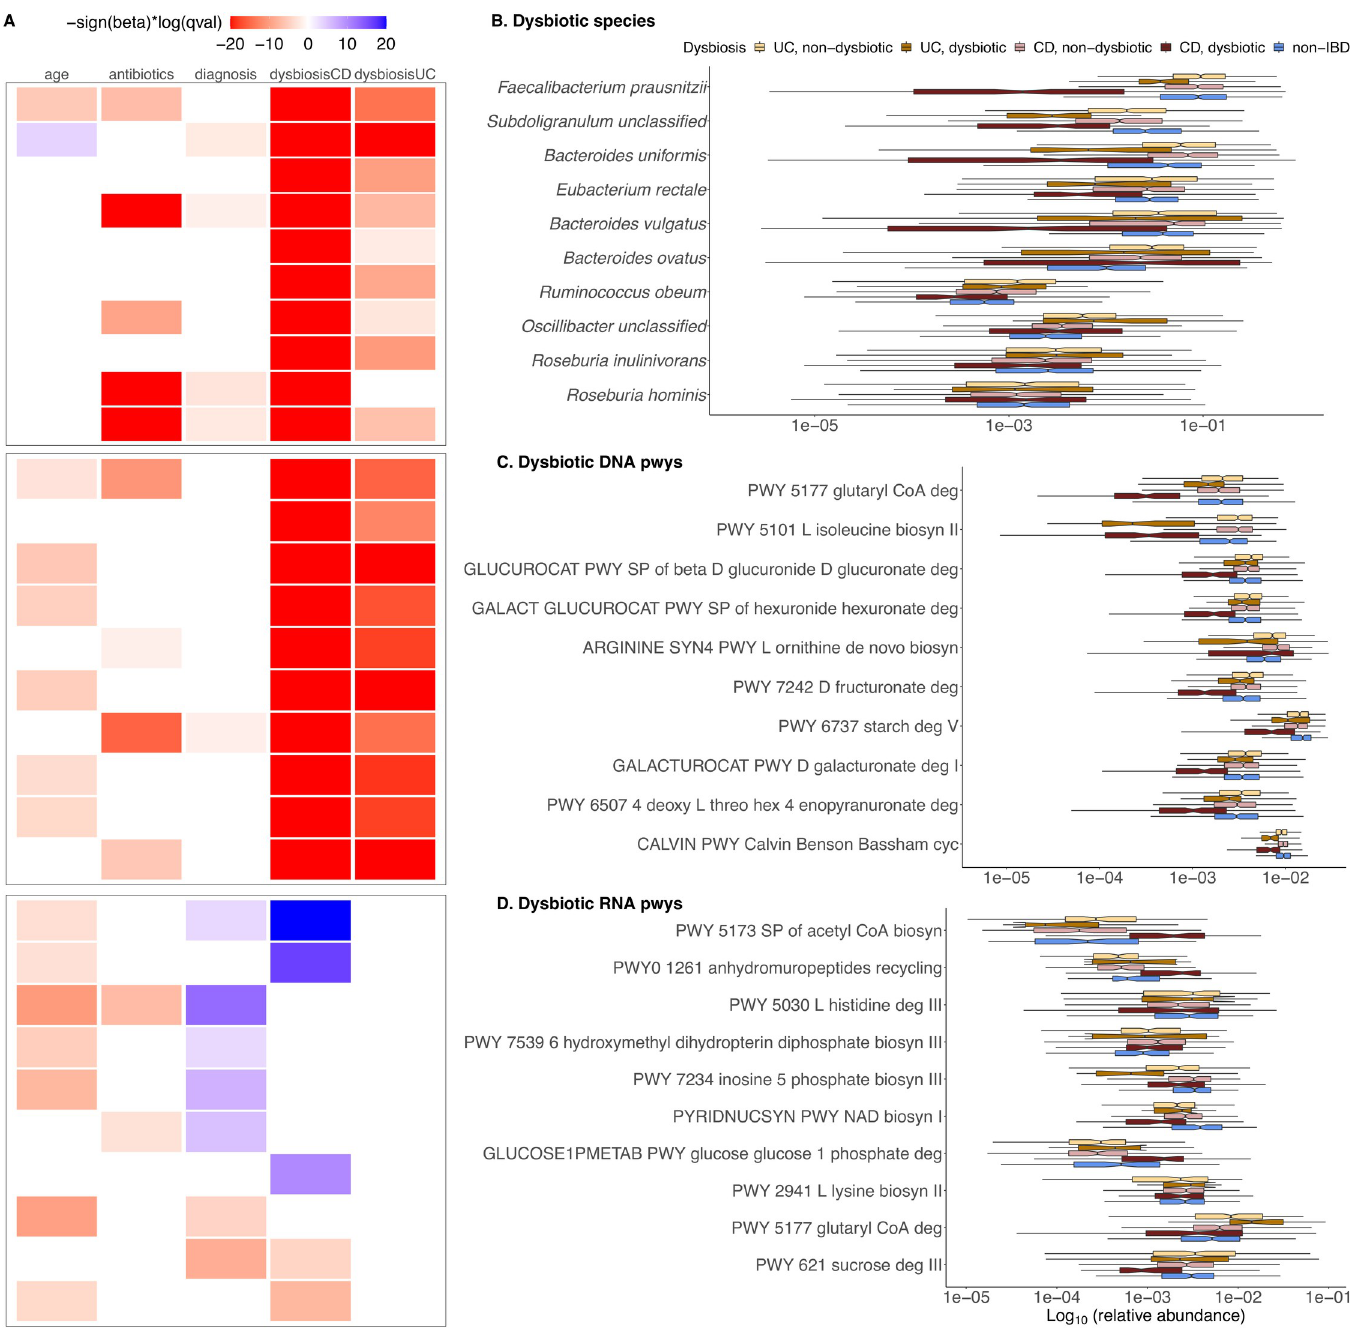
Fig 5. Multi-omics associations from the Integrative Human Microbiome Project. A) Top 10 significant associations (FDR < 0.25) detected by MaAsLin 2’s default linear model (full results in S9–S14 Data ). All detected associations are adjusted for subjects and sites as random effects and for other fixed effects metadata including the subject’s age, diagnosis status (CD, UC, or non-IBD), disease activity (defined as median Bray-Curtis dissimilarity from a reference set of non-IBD samples), and antibiotic usage. B,C,D) Representative significant associations with dysbiosis state from each omics profile are shown: species ( B ), metagenomic (DNA) pathways ( C ), and metatranscriptomic (RNA) pathways ( D ). Values are log-transformed relative abundances with half the minimum relative abundance as pseudo count.